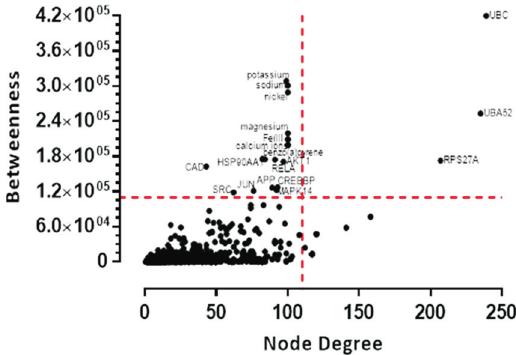
Figure 1 - Scatter plot of degree and betweenness values for all nodes. Hubs (high degree), bottlenecks (high betweenness), and nodes with high relative values in both parameters are identified.